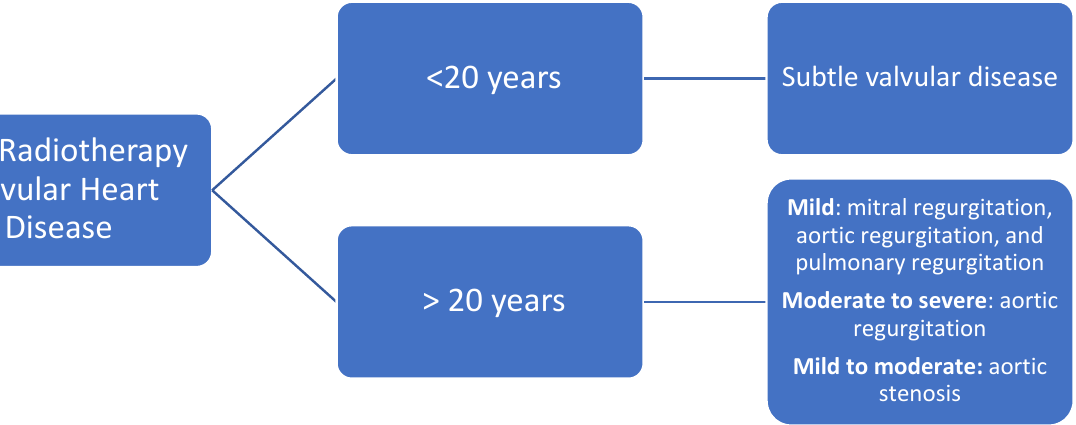
Figure 2. Most common types of valvular disease post radiotherapy [3,79].